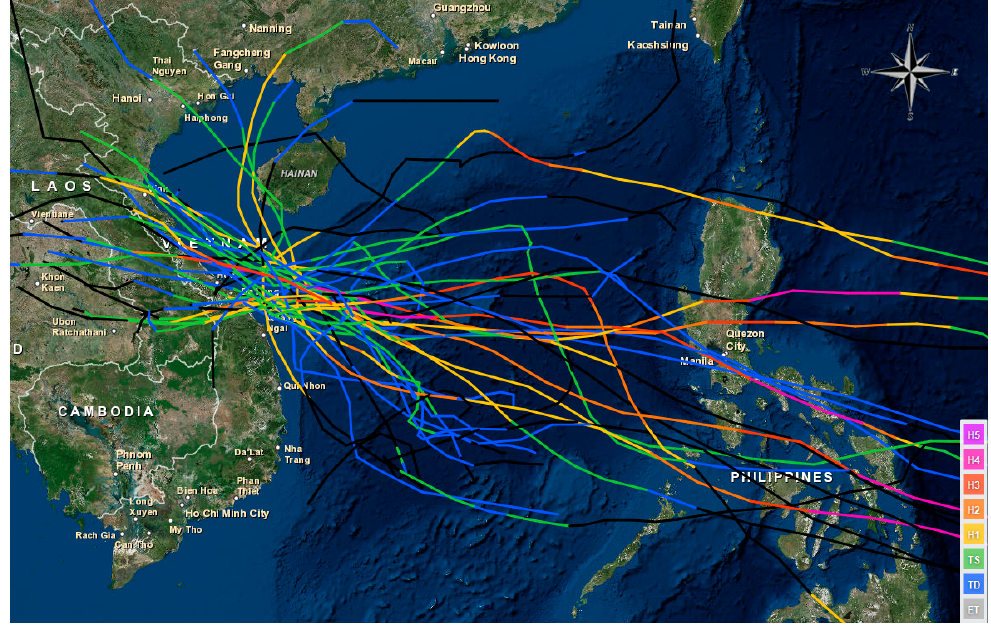
Figure 6. Historical typhoon tracked off the Cua Dai estuary, Central Vietnam during the period from 1964 to 2013 (Imagery source http://coast.noaa.gov/hurricanes/).